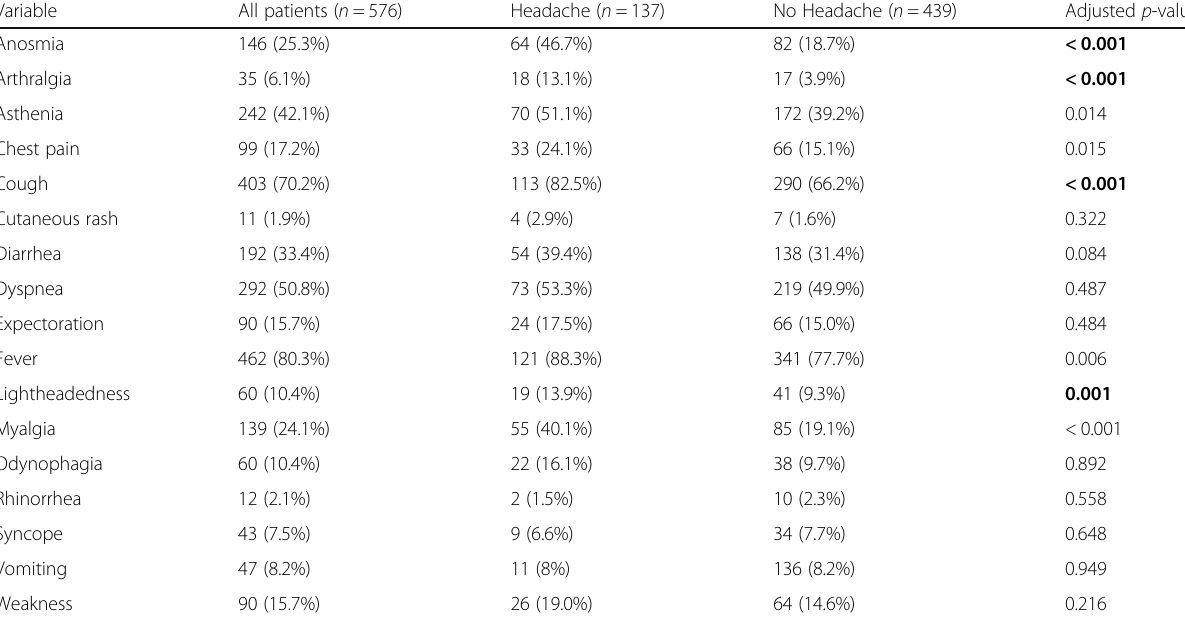
Table 3 Frequency of associated symptoms in the entire sample and the comparison between patients with and without headache